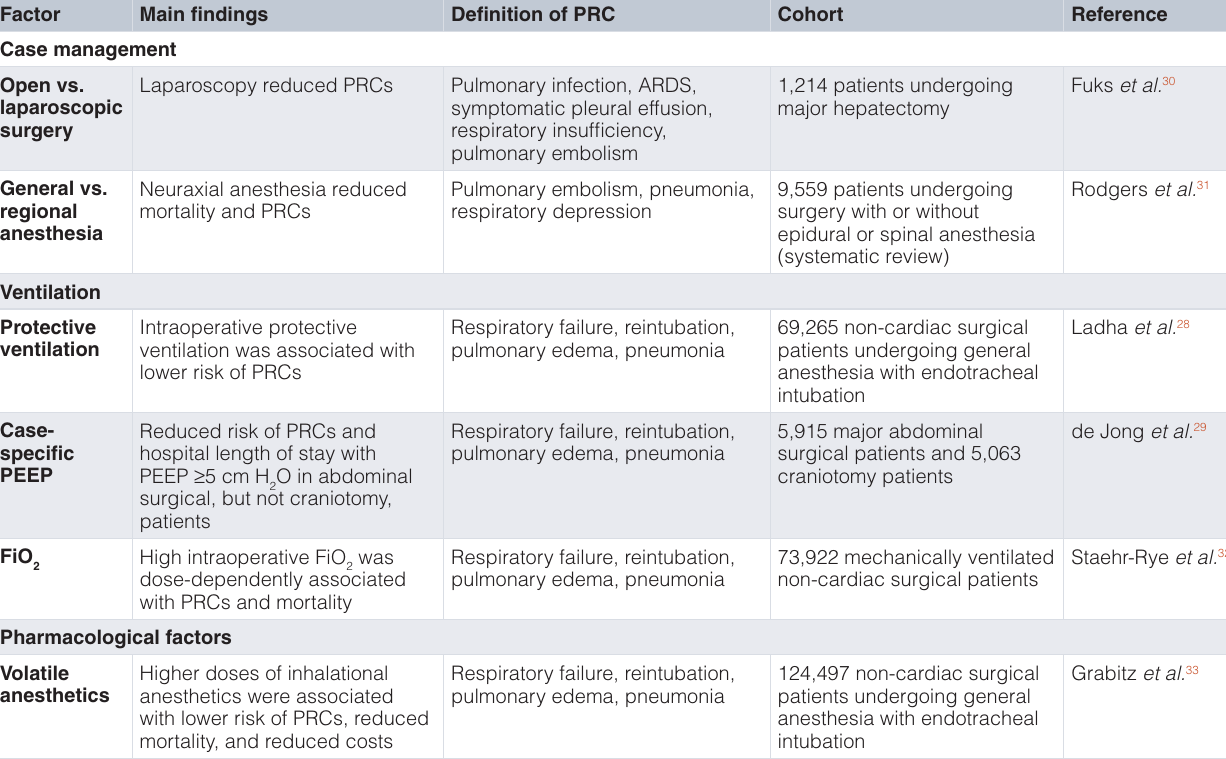
Table 1. Perioperative factors associated with postoperative respiratory complications